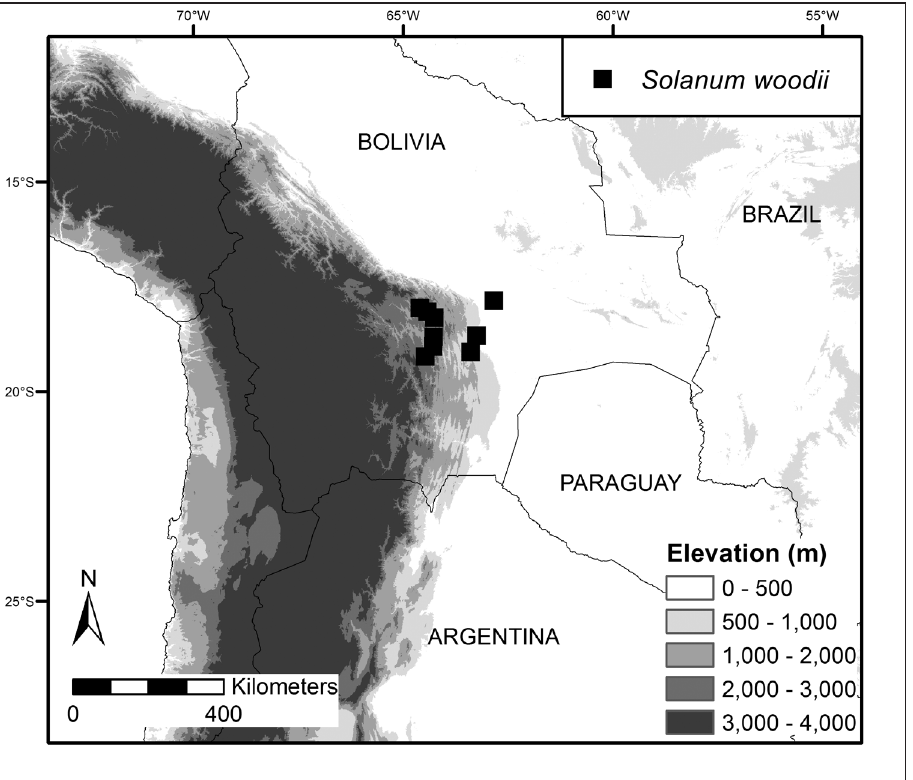
Figure 4. Distribution map of Solanum woodii